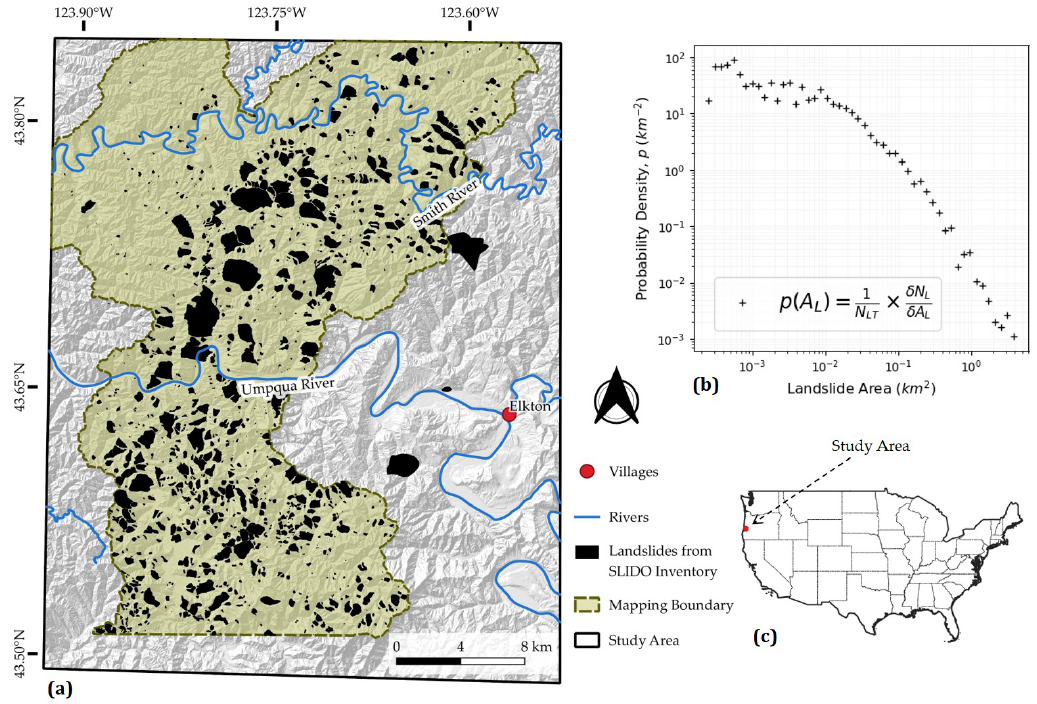
Figure 3. ( a ) The landslide inventory map of the study area extracted from SLIDO database. Mapping boundary shows the spatial extent of inventory mapping done by [80] in 2017. Landslide present outside this boundary are records of past landslides which are present in SLIDO database. This map is in UTM Zone 10N with WGS 84 datum (EPSG:32610). ( b ) The magnitude-frequency plot of the landslides in the study area, where p ( A L ) is the probability density function, A L is the area of the landslide, N LT is the total number of landslides in the inventory, and δ N L is the number of landslides with areas between A L and A L + δ A L . ( c ) Location overview of the Douglas County study area (marked in red) in Western Oregon, USA. This map is in Pseudo-Mercator with WGS 84 datum